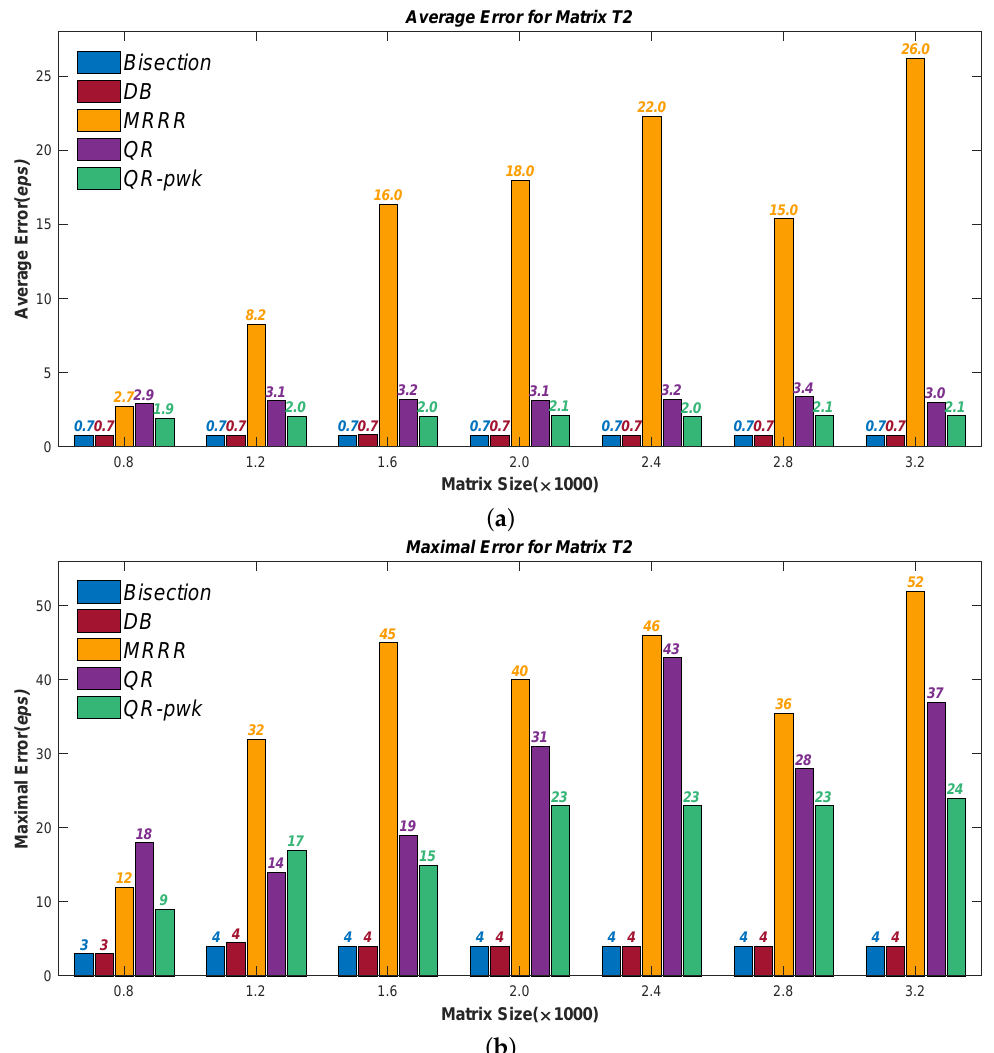
Figure 3. Results of Matrix T2: ( a ) the Average Errors; ( b ) the Maximal Errors. Average Error for Matrix T3